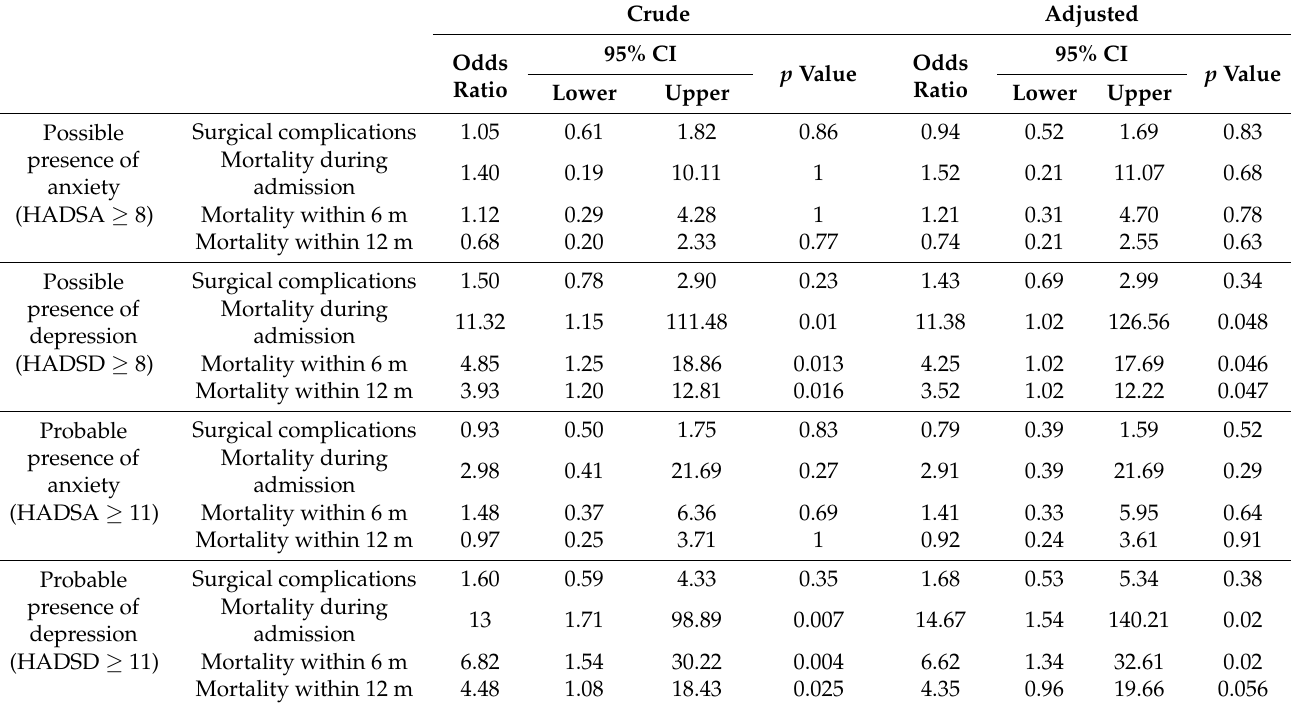
Table 3. Risk of surgical complications and mortality according to anxious or depression symptoma- tology. Adjusted for nutritional